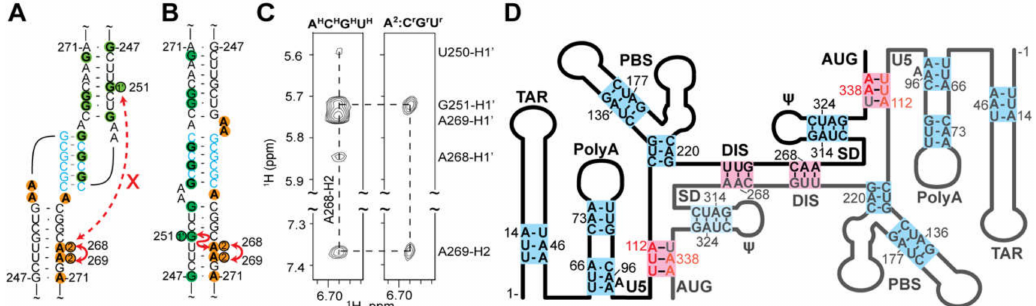
Figure 9. Discrimination between kissing and extended duplex base pairing in the HIV-1 NL4-3 5 (cid:48) -leader by 2 H-edited lr-AID NMR. ( A , B ) Cross-strand NOEs between A268-H2 and G251-H1 (cid:48) establish the nature of the intermolecular interface in the kissing ( A ) versus extended duplex ( B ) interfaces (green dots = G r labeling; orange dots = A 2 labeling). ( C ) A268-H2 to G251-H1 (cid:48) NOEs in both A 2 G r and A 2 :G r C r U r support an extended duplex interface. ( D ) Summary of intermolecular (pink) (U5:AUG and DIS) and intramolecular (blue) (TAR, PolyA, PBS, Ψ ) base pairings detected by NMR. Reproduced from [226], with